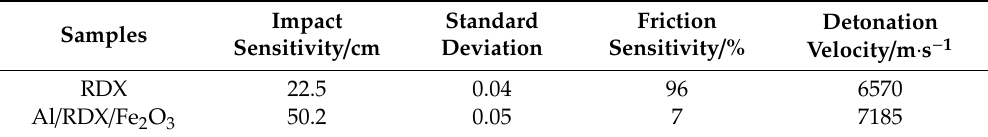
Table 1. Hazardous properties of RDX and di ff erent